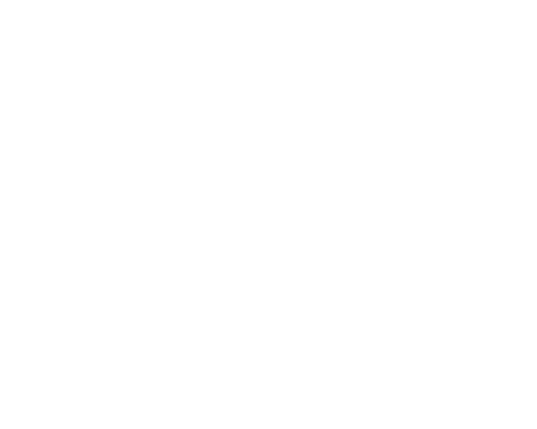
Figure A2. Imaging convention for each coupon in the experiment. Regions were chosen to reflect the corners (1–4), edges (5–8), central area (9–12), and absolute center (13) of each sample.